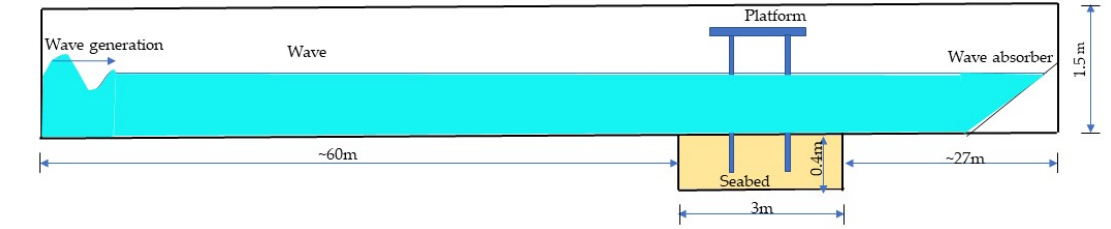
Figure 1. General layout of the offshore platform structure in the wave flume. Table 1. Basic physical parameters of the model’s soil. Specific gravity of the soil particle G (cid:3046)